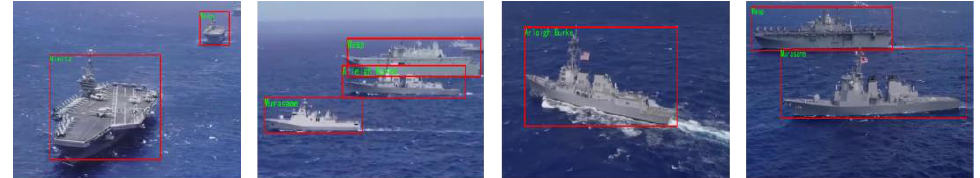
Figure 11. Detection and classification